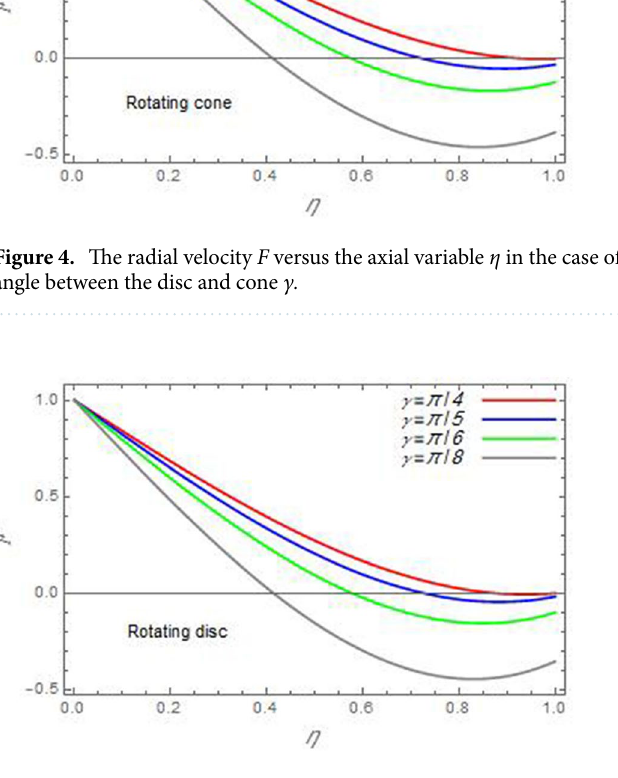
Figure 5. The radial velocity F versus the axial variable η in the case of stationary cone to depict the effect of the angle between the disc and cone γ .